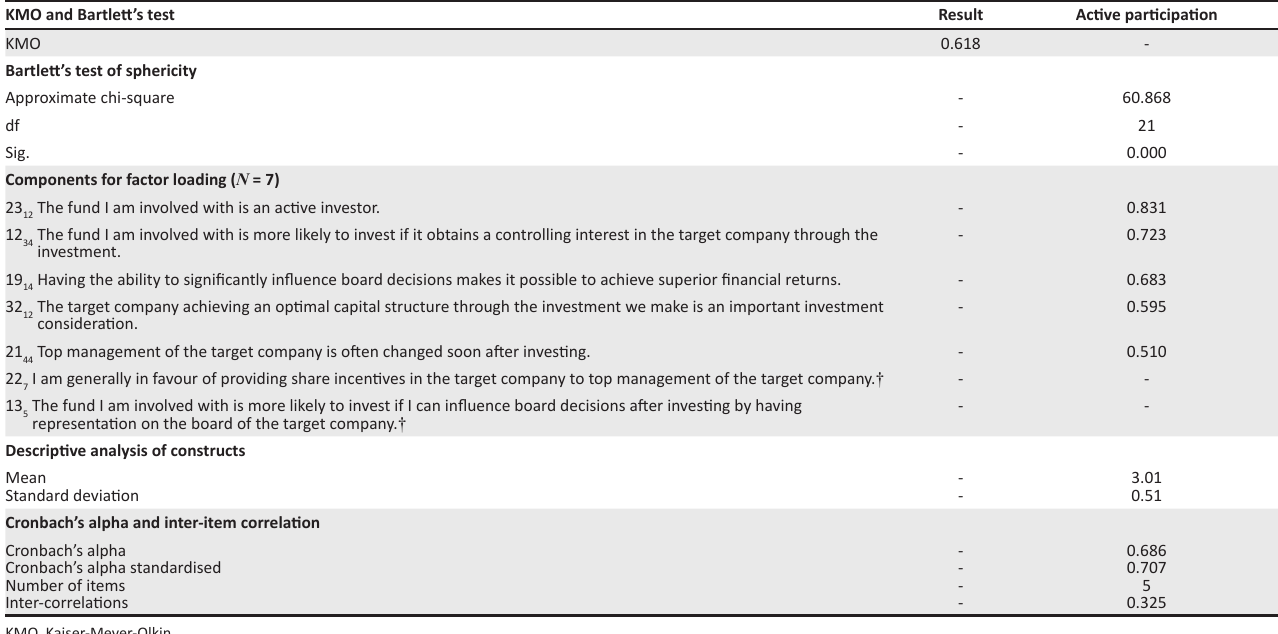
TABLE 3-A1: Making impact on the target